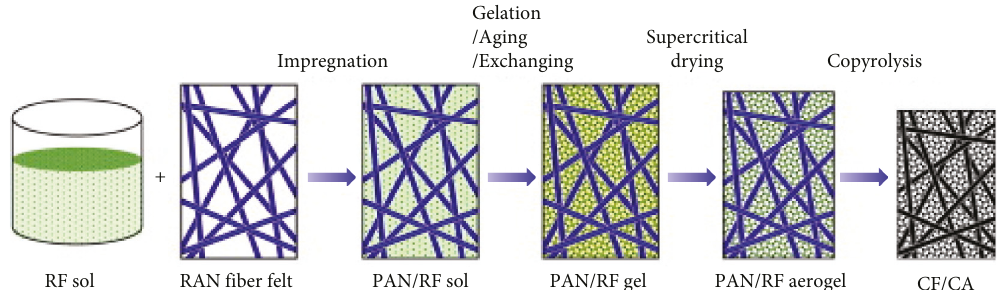
Figure 15: Schematic illustration for the synthesis of aerogel [135].